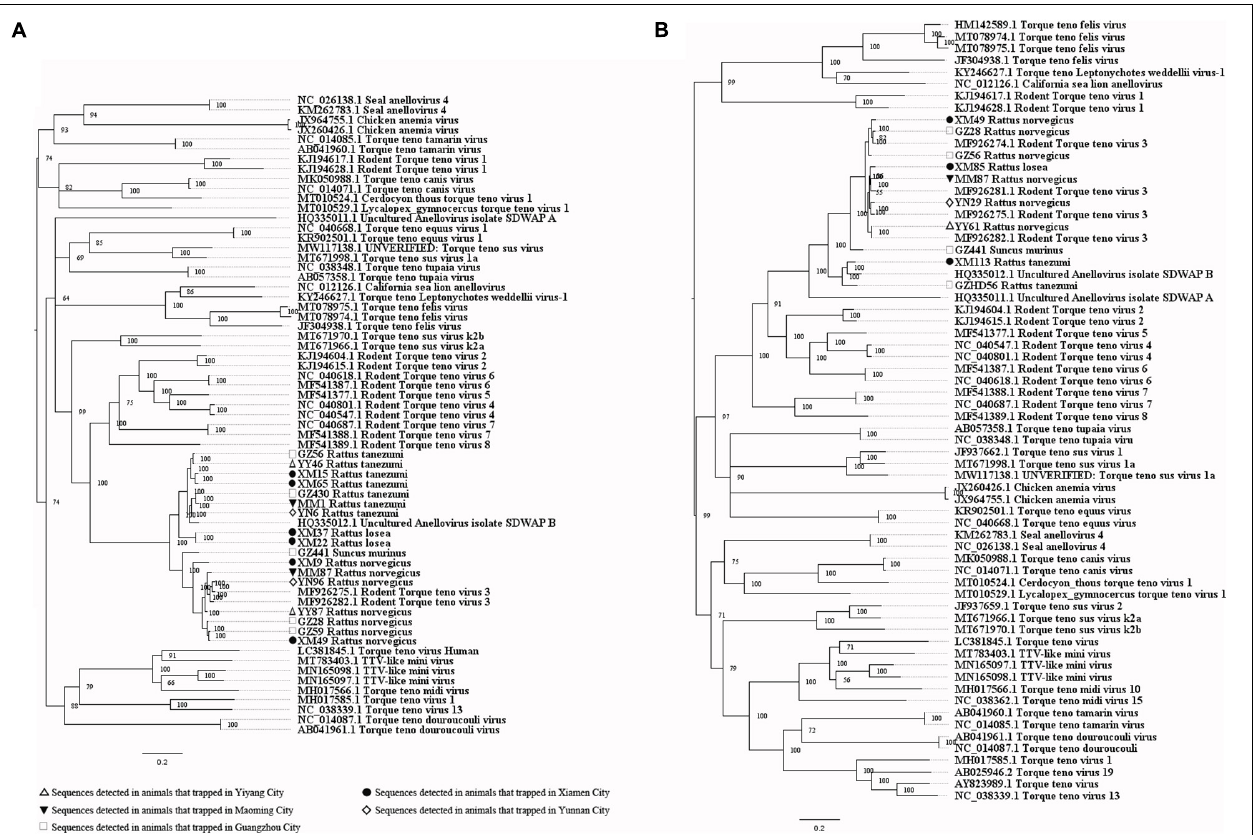
FIGURE 10 | (A) Phylogenetic tree constructed based on PCR-screened nucleotide sequences (651 bp) of TTV from urban rats and house shrews (MrBayes, GTR + G + I nucleotide substitution model). A total of 48 representative sequences of different genera within family Anelloviridae are included for comparison (ORF1 region). Percentages of the posterior probability (PP) values are indicated. This tree is rooted using the model and not by the reference to an outgroup. (B) Phylogenetic tree constructed based on near full-length nucleotide sequences (2190 bp) of TTV from urban rats and house shrews (MrBayes, GTR + G + I nucleotide substitution model). A total of 56 representative sequences of different genera within family Anelloviridae are included for comparison. Percentages of the posterior probability (PP) values are indicated. This tree is rooted using the model and not by the reference to an